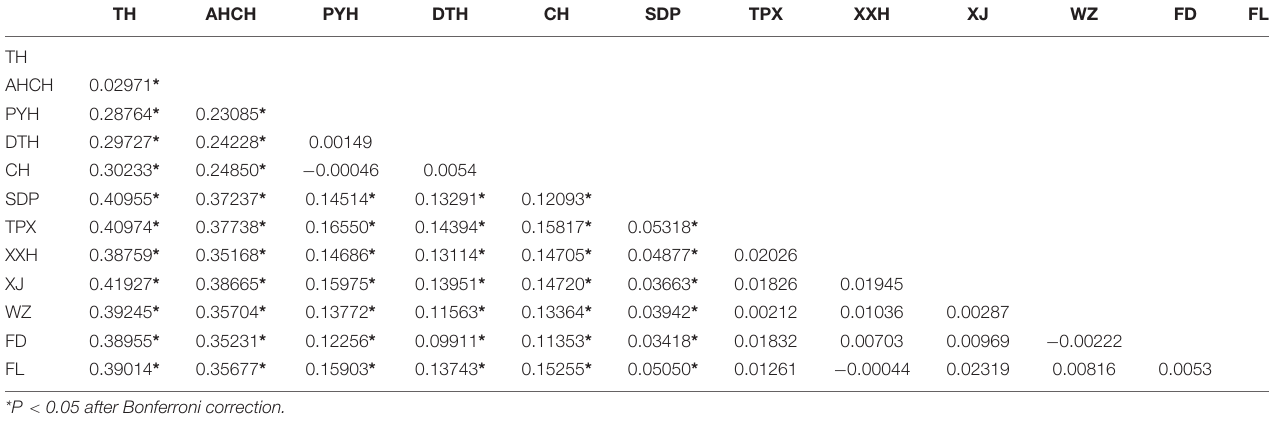
TABLE 5 | Pairwise F ST values based on SSR analysis of 384 samples of C. brachygnathus from 12 different sites in the Yangtze River Basin, China.